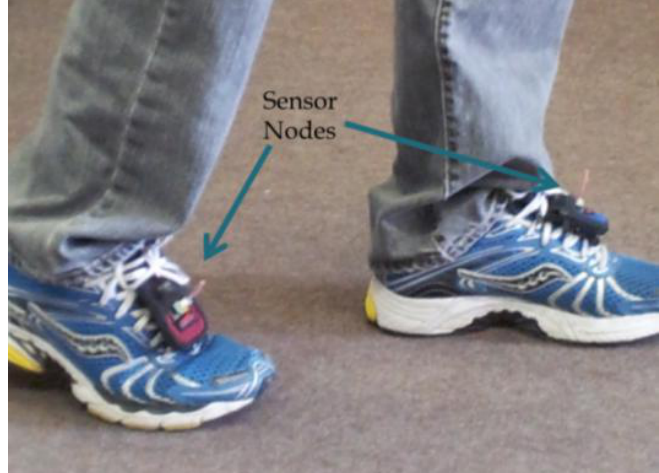
Figure 4. For gait classification, two sensor nodes are attached to each feet. The sensor nodes send the RSSI of each other through the base station to a processing unit to classify the